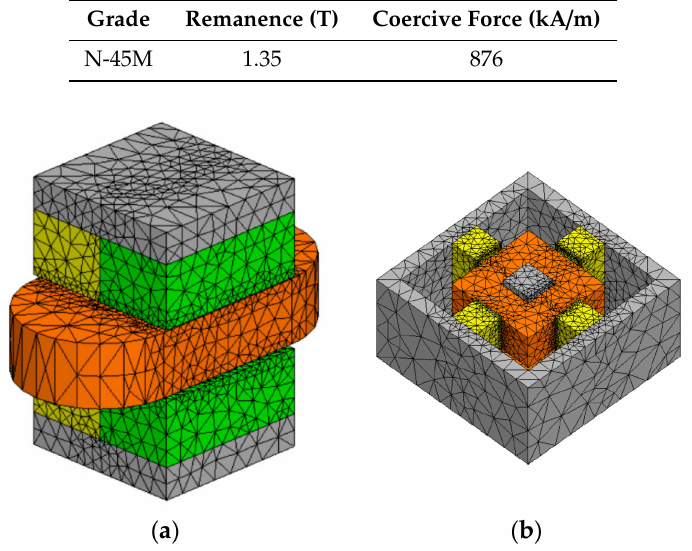
Figure 5. ( a ) Meshed simulation model of HVCM with nominal dimensions, ( b ) Meshed simulation model of VVCM with nominal